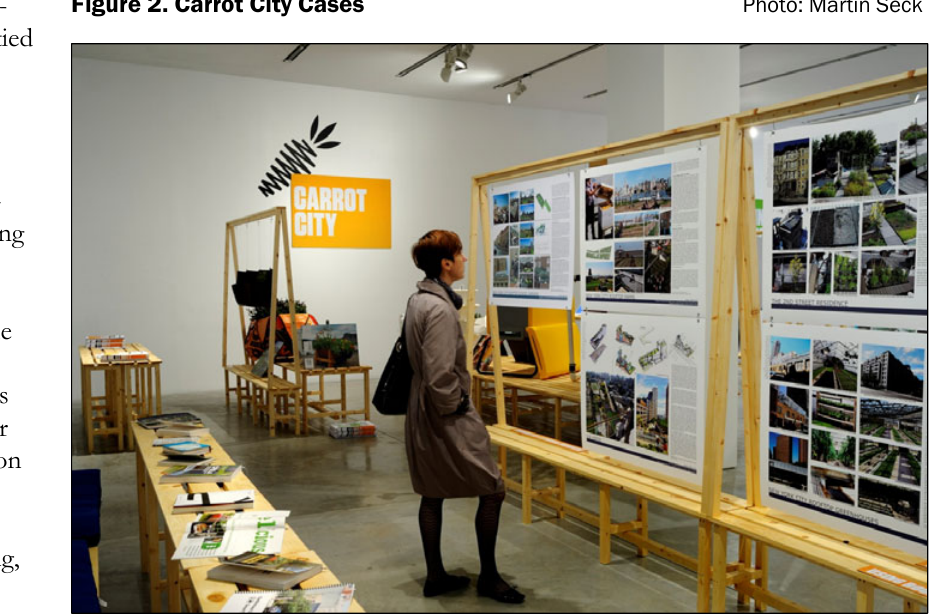
Figure 2. Carrot City